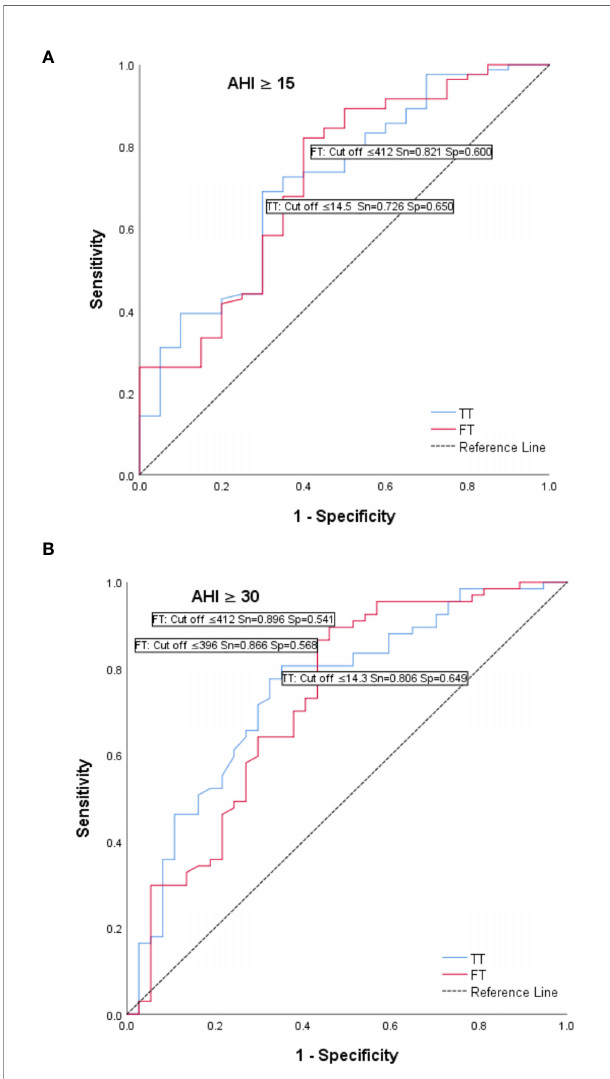
FIGURE 3 | Receiver operating characteristic (ROC) curves – total testosterone (T) and tree testosterone (FT) as discriminative variables for the assessment of sleep apnea severity. (A) AUC for AHI ≥ 15 for TT was AUC T = 0.714 (95% CI 0.587 - 0.841; p = 0.003) with cut off = 14.5 (Sn = 0.726; Sp = 0.650), and for FT AUC FT = 0.719 (95% CI 0.588 - 0.851; p = 0.002) with cut off = 412 (Sn = 0.821; Sp = 0.600). (B) AUC for AHI ≥ 30 for TT was AUC T = 0.748 (95% CI 0.648 - 0.849; p < 0.001) with cut off = 14.3 (Sn = 0.806; Sp = 0.649) and for FT AUC FT = 0.728 (95% CI 0.620 - 0.836; p < 0.001) with cut off = 396 (Sn = 0.866; Sp =